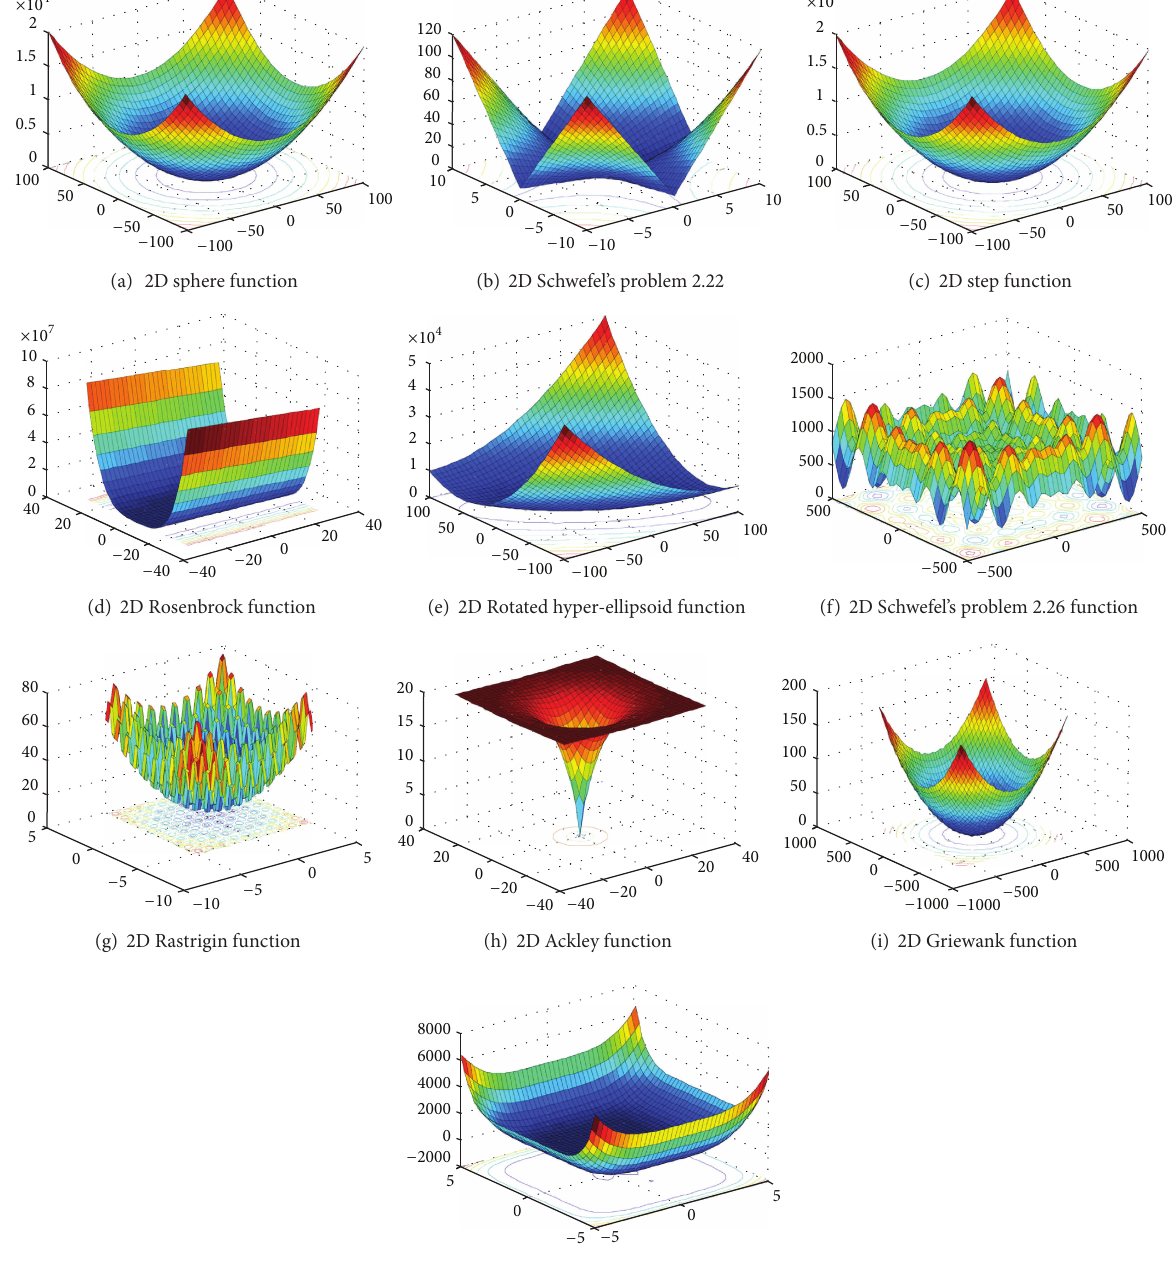
Figure 7: The benchmark functions landscape where the value of 𝑁 = 2 (2